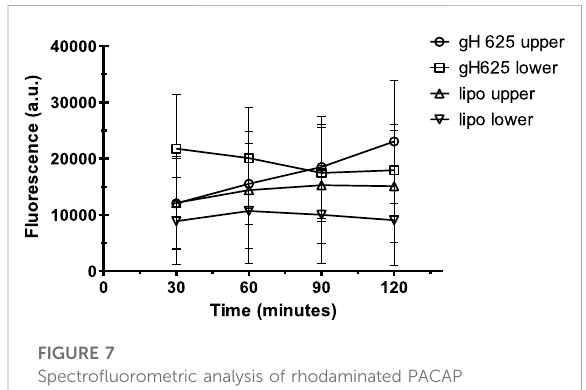
FIGURE 7 Spectro fl uorometric analysis of rhodaminated PACAP (PACAP-Rho)deliveryacrosstheBBBdynamic invitro model.After 30 min the fl uorescence ofgh625-lipoPACAP-Rho is higher in the lower chamber of LB2 compared to lipoPACAP-Rho.